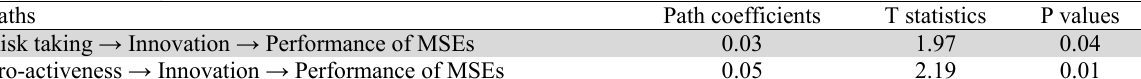
Mediation testing Paths Path coefficients T statistics P values Risk taking → Innovation → Performance of MSEs 0.03 1.97 0.04 Pro-activeness → Innovation → Performance of MSEs 0.05 2.19 0.01